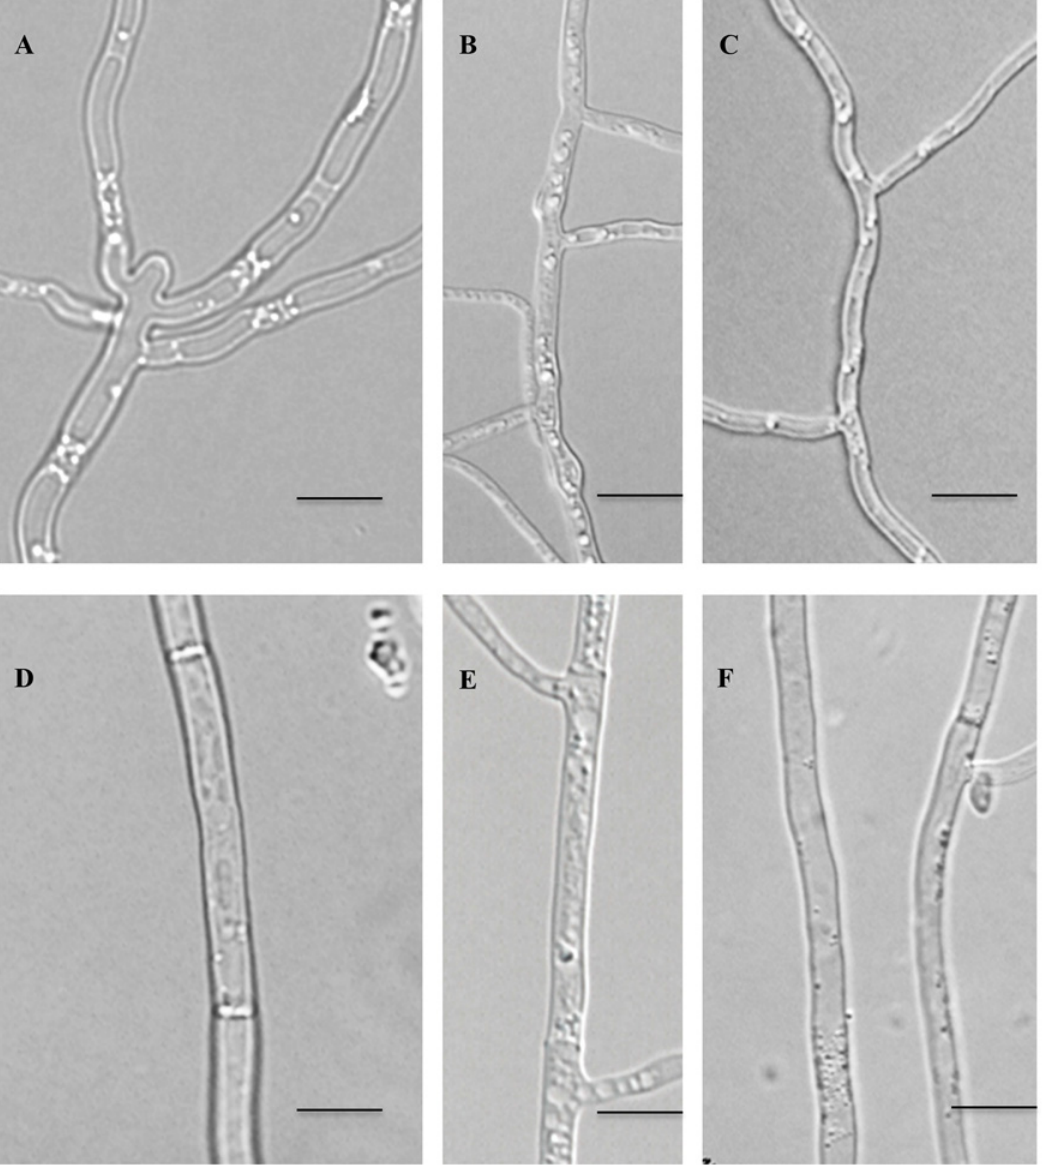
Fig 1. Hypha morphology of WT, mutants Δ FoSlt2 , Δ FoMkk2 and Δ FoBck1 , and complemented strains Δ FoSlt2 -c and Δ FoMkk2 -c. Strains were incubated at 28°C for 4 days on PDA plates. A: Δ FoSlt2 , B: Δ FoMkk2 , C: Δ FoBck1 , D: WT, E: Δ FoSlt2 -c, F: Δ FoMkk2 -c. Bars: 10 μ m.